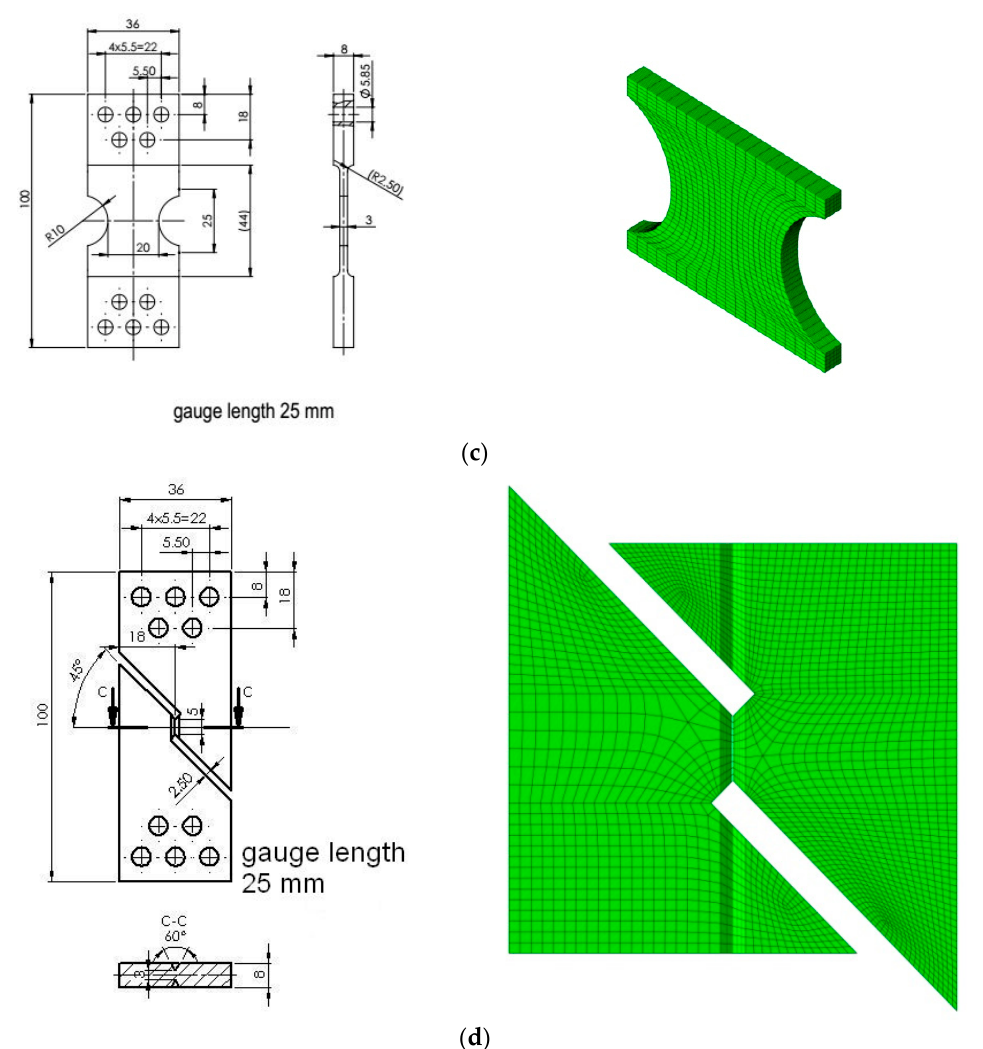
Figure 3. Mechanical drawings and finite element mesh images of tested specimens: ( a ) two-notched cylindrical specimens C04 with R = 0.4 mm ( η ≈ from 0.5 to 1.6, L ≈ from 0.6 to 1) and C1 with R = 1 mm ( η ≈ from 0.4 to 1.4, L ≈ from 0.85 to 1); ( b ) plate with side groove (PN), R = 1 mm ( η ≈ 0.4, L = 0.4); ( c ) plate with R = 10 mm (PR) ( η ≈ 0.5, L = 0.5); and ( d ) pure shear (S) ( η ≈ 0, L = 0) (Source: authors’ drawings).